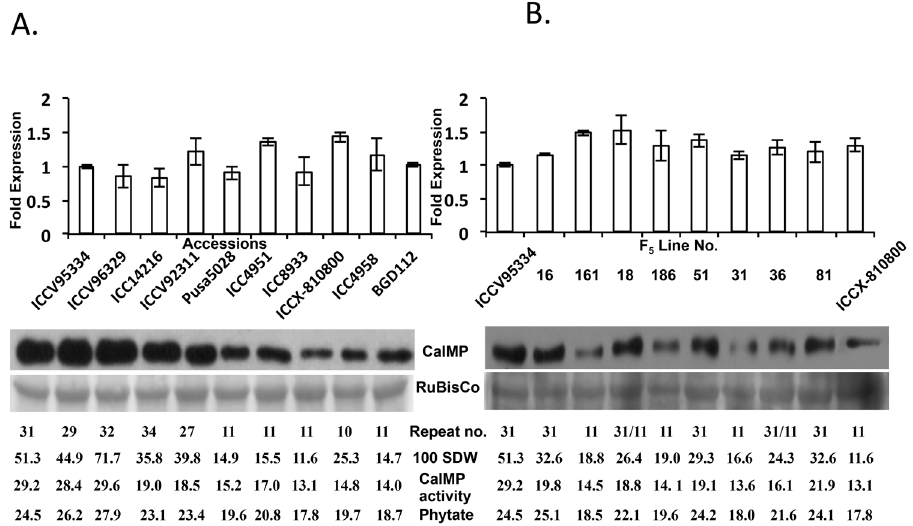
Figure 2. Expression analysis of CaIMP in accessions and mapping individuals: qRT-PCR analysis (top) and western blot analysis (bottom) of CaIMP gene and protein expression in 10 different chickpea germplasm accessions ( A ) and in 8 individuals of F 5 mapping population of ICCV95334 × ICCX-810800 ( B ). CT repeat number, 100 Seed weight (100 SDW in gram), CaIMP specific activity ( μ mol Pi mg − 1 protein min − 1 ), and seed phytate content (mg PA/gm) of 10 chickpea germplasm accessions and 8 individuals of mapping population are shown. Chickpea Elongation factor 1- α (CaEF-1 α ) was used as internal control for normalization in